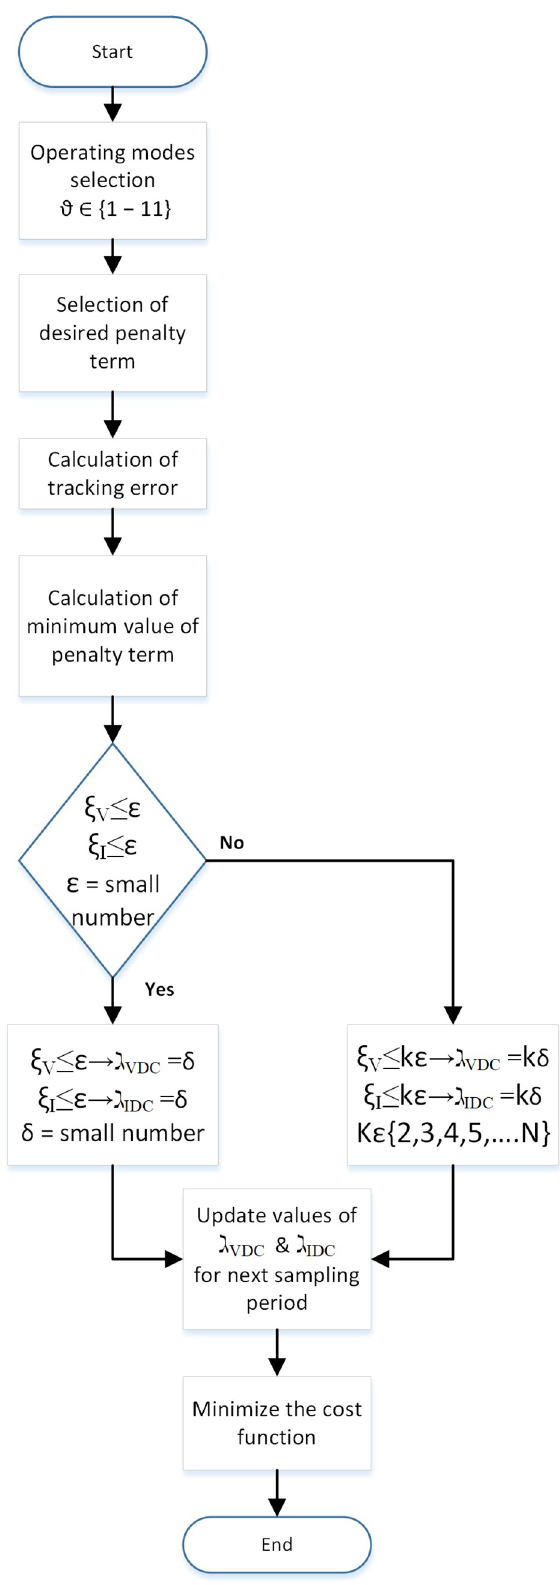
Fig 10. Auto-tuning algorithm of the weight factors in the cost function. https://doi.org/10.1371/journal.pone.0278110.g010 PLOS ONE | https://doi.org/10.1371/journal.pone.0278110 January 20,